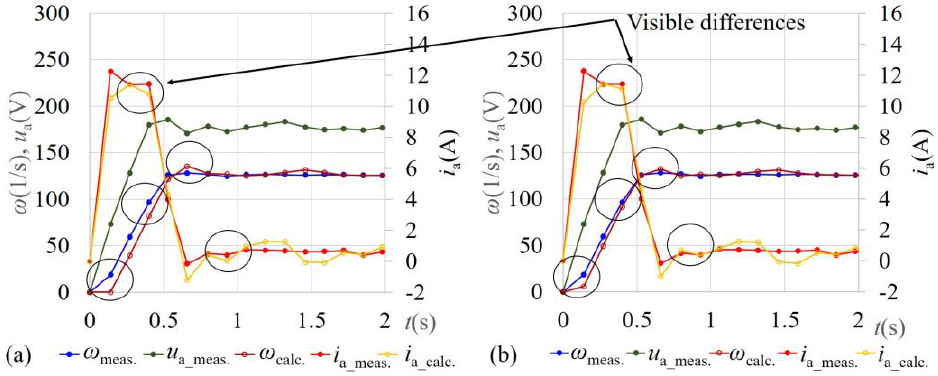
Figure 8. Measured and calculated responses in the case of MD1 using: ( a ) EM; ( b ) RK.